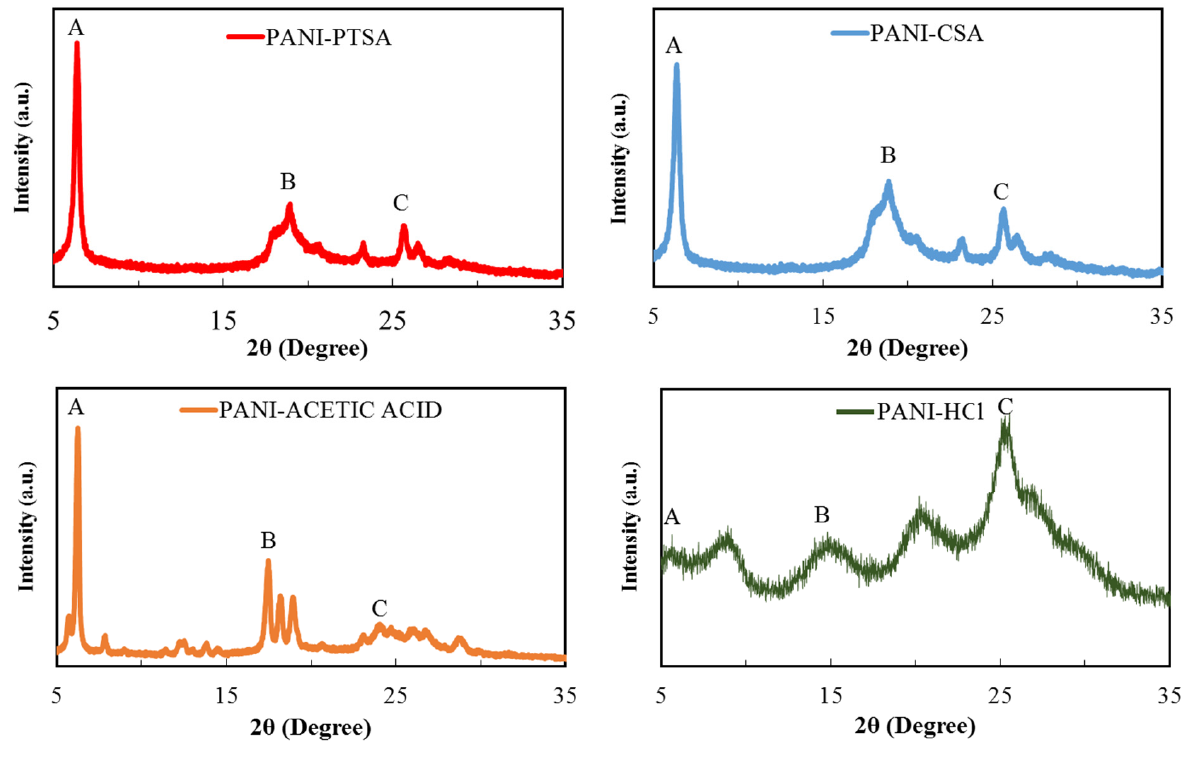
Figure 3. XRD spectra of synthesized PANI samples. Table 4. Crystallite size, d-spacing and interchain division of PANI samples exposed over various shots of ES reflection (measured from XRD).